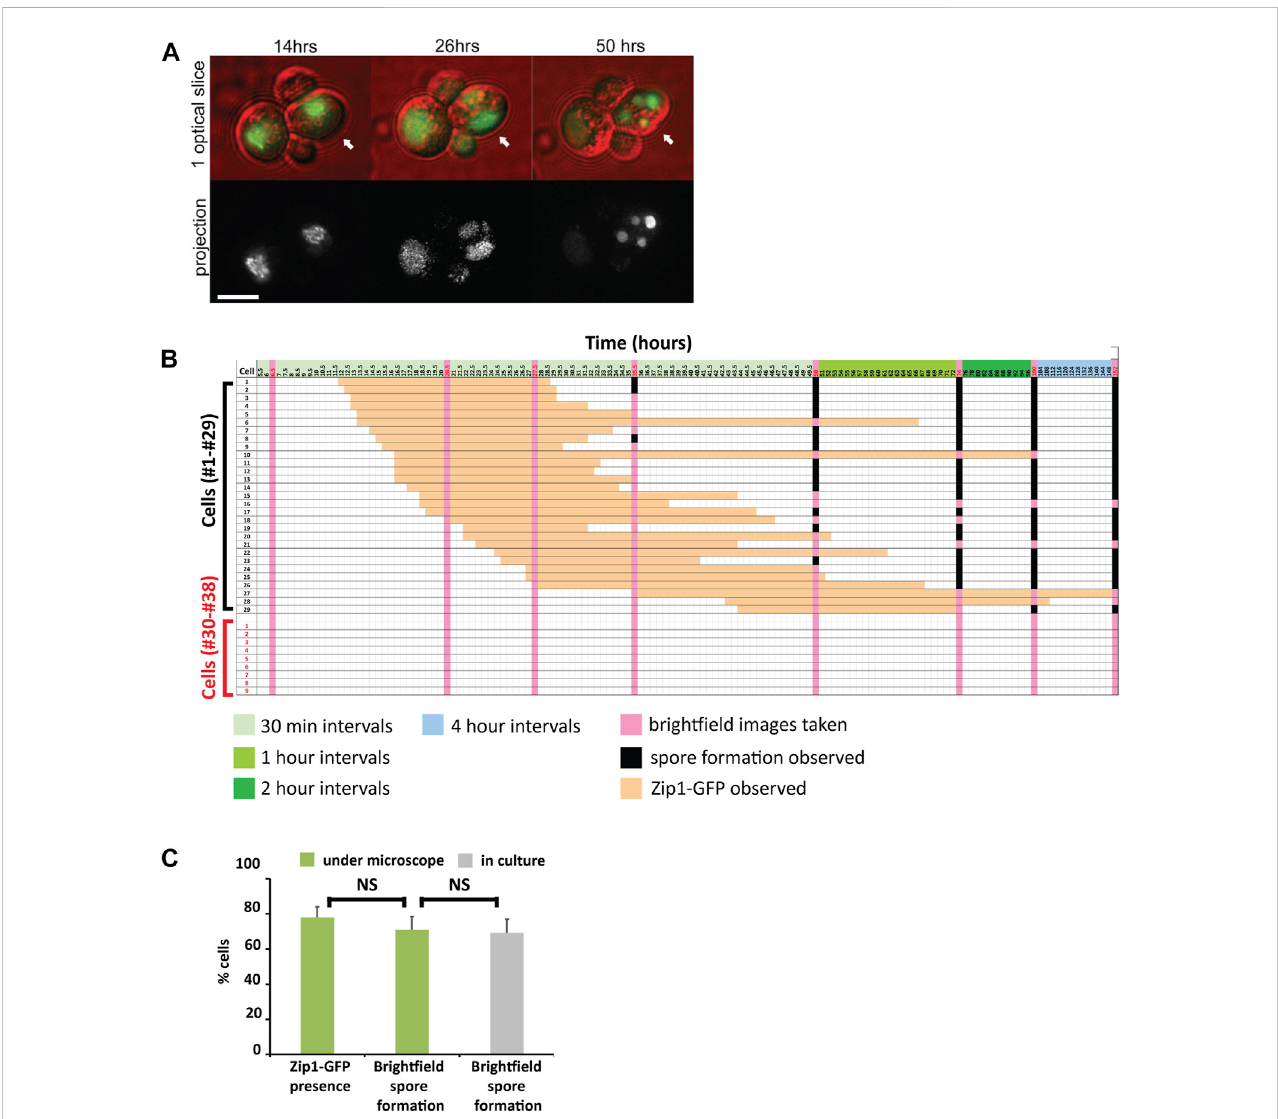
FIGURE 3 Imaging conditions do not perturb meiotic progression (A) Examples of Zip1-GFP and spore formation examples are shown at three timepoints as meiosis progresses in live cells. Zip1-GFP signal (green) is overlayed by bright fi eld to detect cell and spores (red). Both single optical slice and 2D projections areshown.Although3 cellsshowZip1-GFPexpressionduringthetimecourse,onlyoneprogressestosporeformation.Scalebar5 µm. (B) Cellsweretracked for meiotic progression for 152 h to determine the frequency of cells that enter meiosis as well as the frequency of cells that eventually form spores, to determineiftheimagingconditionsperturbedsporulation.Arepresentativeexperimentinwhich38cellsweretracked,ofwhich29enteredmeiosis(cellswith black numbers, fi rst column) as determined by Zip1-GFP detection (orange squares) and 9 (cells with red numbers) did not. Cells were imaged for Zip-GFP initially at 30-minute intervals until 50 h(pale green, top column headers), then 1-hour intervals until 74 h(olive green), then 2-hour intervals until 100 h (dark green), followed by 4-hour intervals until 152 h (blue). At 6.5, 20.5, 27.5, 35.5, 50, 74, 100, and 152 h, bright fi eld images were acquired to assess for spore formation (pink columns). Black boxes indicate when spores were detected. (C) The number of cells entering meiosis and the number of cells forming spores are compared. Cells were counted if any spores (1 – 4) were observed. The average percentages were determined from fi ve experiments performed as described in (B) above. A total of 179 cells were tracked. Experiments performed under the microscope using our optimized imaging conditions are shown in green. The frequency of sporulation was also calculated by counting spore formation in bright fi eld for comparison (gray) after 5 days of normal culturing in fl asks.